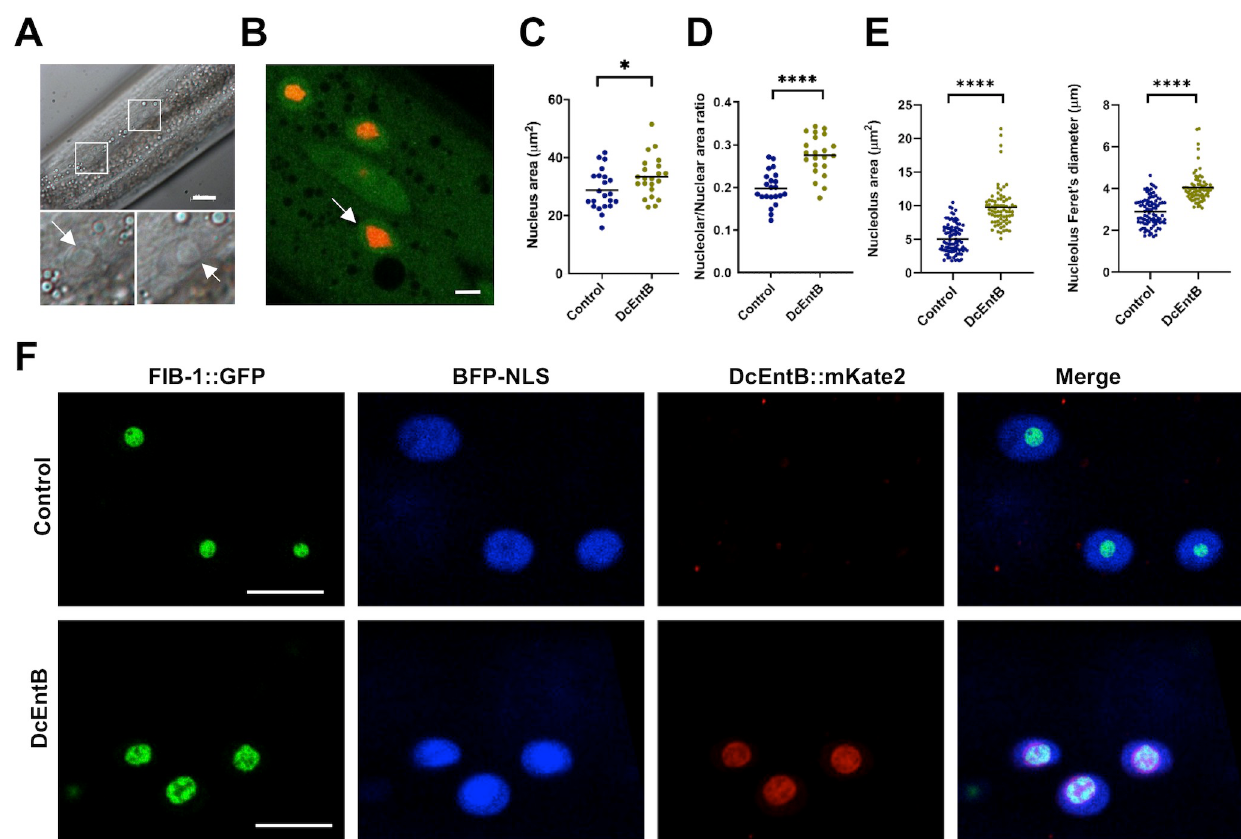
Fig 7. DcEntB makes nucleoli irregular and larger. ( A ) Representative Nomarski image of a young adult worm expressing DcEntB::mKate2. Scale bar, 10 μ m. Enlarged views of the boxed regions show the large and irregular nucleoli (white arrows). ( B ) Representative confocal image of a young adult worm expressing DcEntB::mKate2 and STA-2::GFP (IG1977) in hyp7. White arrow points to an irregular nucleolus (red). Scale bar, 10 μ m. ( C , D ) Quantification of nuclear size ( C ) and nucleolus/nucleus ratio ( D ) in the epidermis of young adult IG1977 worms (DcEntB) and their siblings without the DcEntB transgene (Control). n > 20 in each strain; bars represent the mean; � p < 0.05, unpaired t-test ���� p < 0.0001, unpaired t-test. ( E ) Quantification of nucleolus area and Feret’s diameter in hyp7 of young adult worms expressing FIB-1::GFP together with (DcEntB; IG1984) or without (Control; IG1596) DcEntB. ���� p < 0.0001. Statistical significance was determined using a nonparametric Mann Whitney test. ( F ) Confocal images of hyp7 nuclei in young adult worms expressing FIB-1::GFP together with (DcEntB; IG1984; lower panels) or without (Control; IG1596; upper panels) DcEntB. All worms also express BFP-NLS; panels from left to right: green, blue, red, and the 3 channels together, scale bar, 5 μ m.